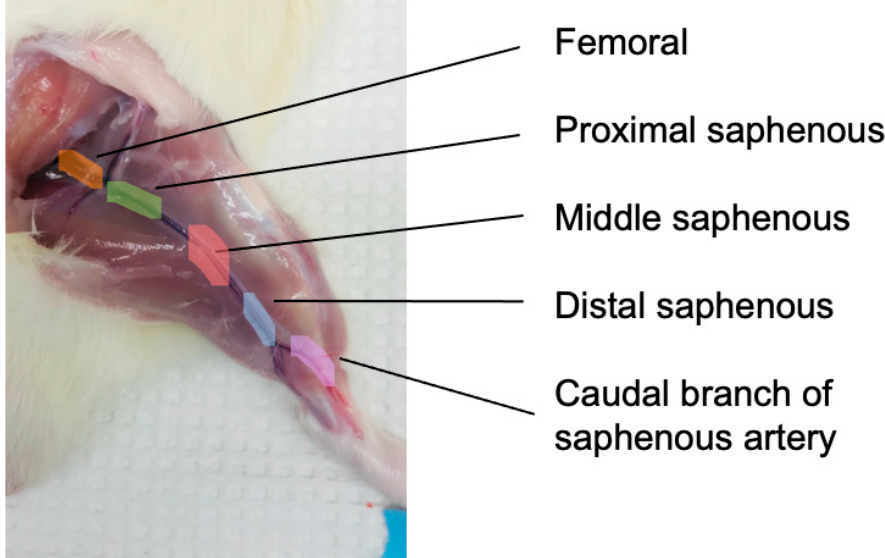
Figure 1. Anatomical representation of hind limb arteries in male Sprague Dawley rat. The femoral artery (orange) is identified as the artery prior to bifurcation into popliteal and epigastric arteries. The saphenous arteries were separated into proximal (green), middle (red), and distal (blue) segments based on distance to the femoral artery. The caudal branch (purple) is one of the bifurcations of the saphenous artery.